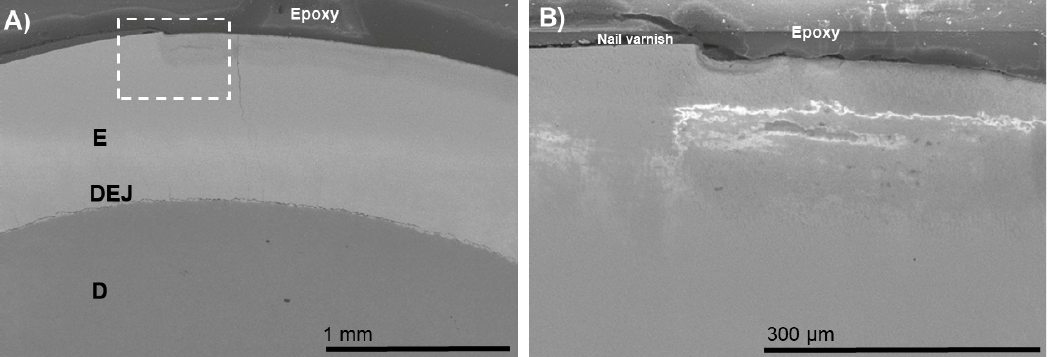
Figure 6. SEM images of the specimens in the bacteria-induced enamel demineralization followed by remineralization in PILP solution containing OPN as process-directing agent and fluoride (BIED- REM OPN-F group). ( B ) High-magnification SEM image of ( A ) showing the area under the dotted outline rectangle. E: enamel; D: dentin; DEJ: dentin–enamel junction.